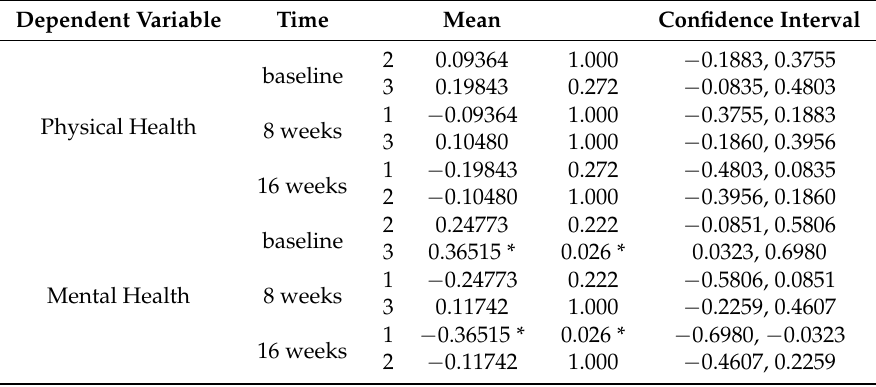
Table 5. Change in